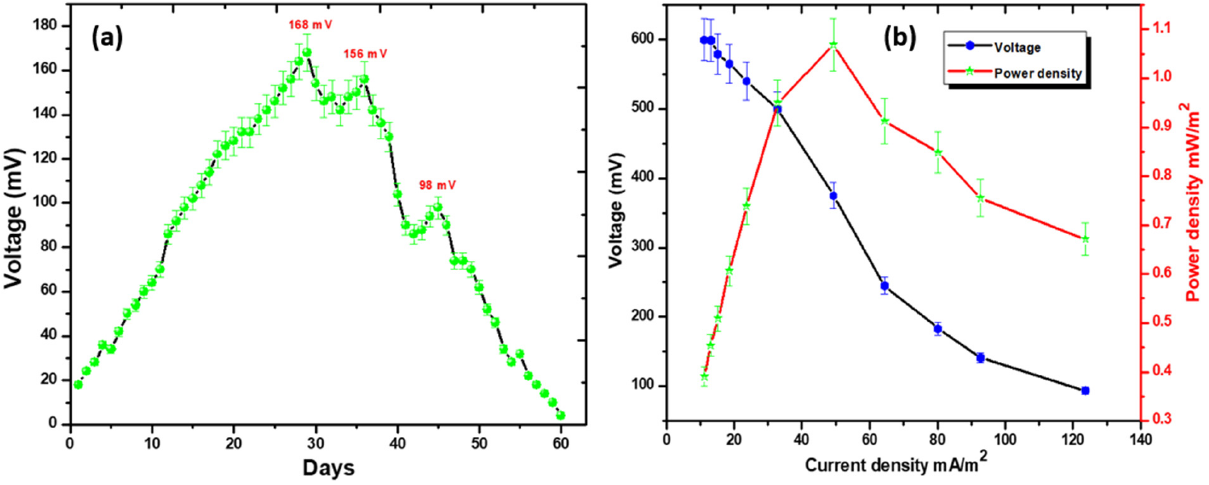
Figure 2. ( a ) Voltage generation trend and ( b ) polarization curve of the present